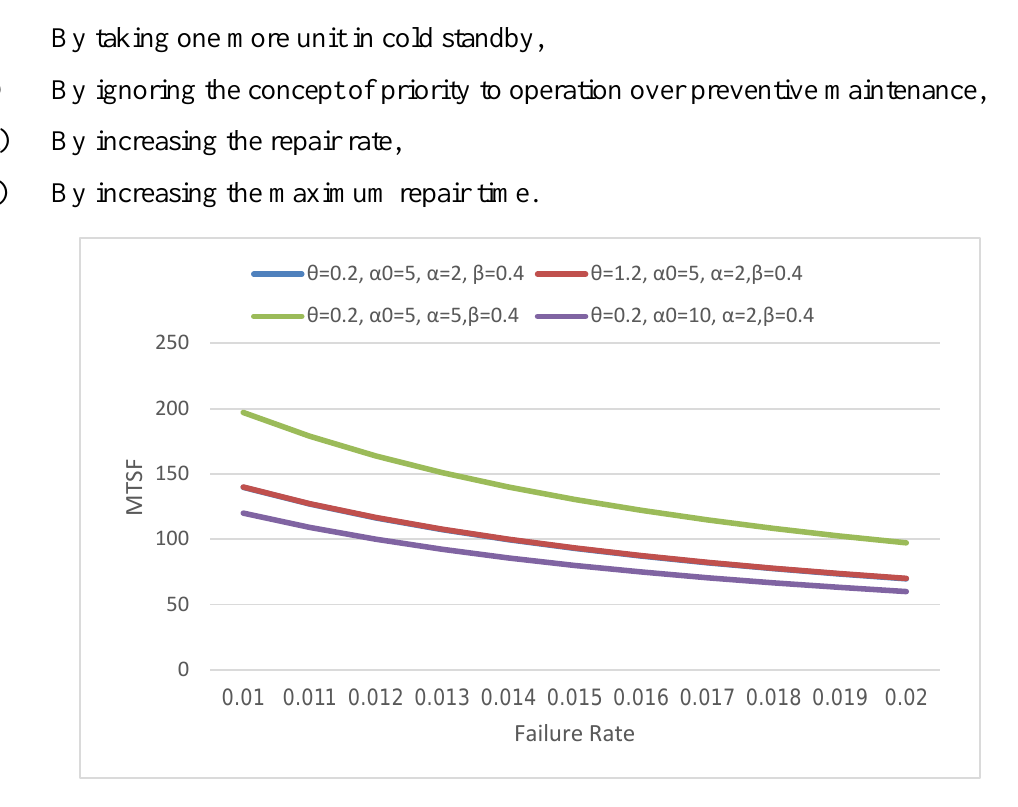
Fig. 1. MTSF vs. Failure